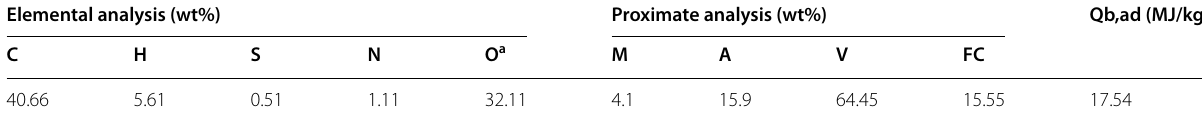
Table 1 the elemental analysis and the proximate analysis of biomass used in the experiment